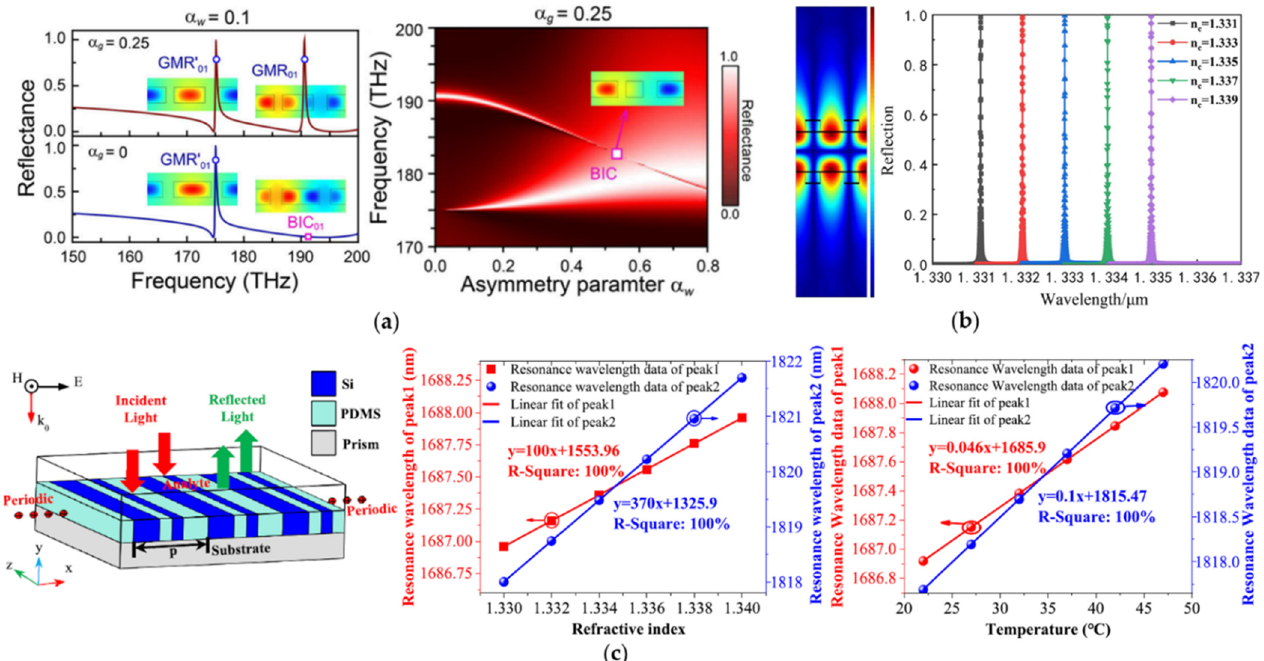
Figure 3. BICs biosensors composed of all-dielectric gratings. ( a ) GMR and BIC modes excited by an asymmetric silicon grating and their Hy field distribution with different degrees of symmetry breaking (reprinted with permission from [57], ©2021, The Optical Society). ( b ) double compound symmetric grating with a localized electric field (reprinted with permission from [58], ©2022, Chinese Optics Letters). ( c ) Si-PDMS symmetry-broken grating with temperature self-compensation function (reprinted with permission from [59], ©2022, IOP).